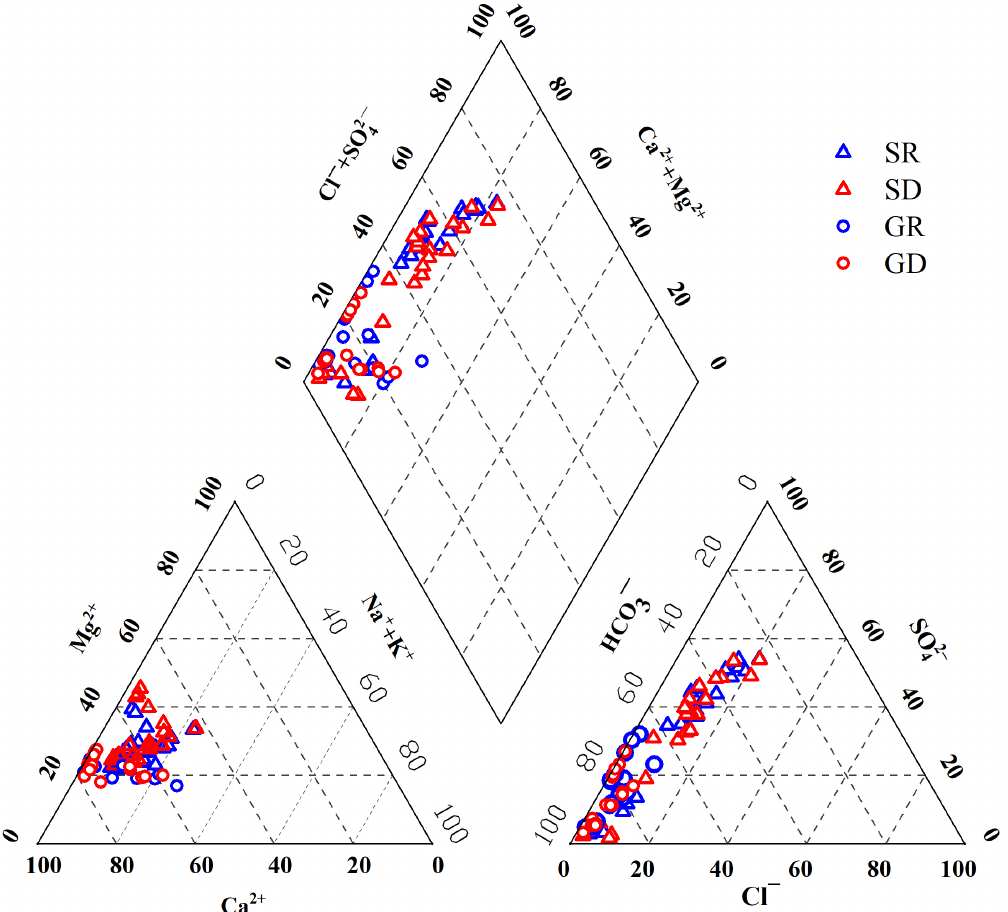
Figure 3. Piper diagram of water samples in NKWS.